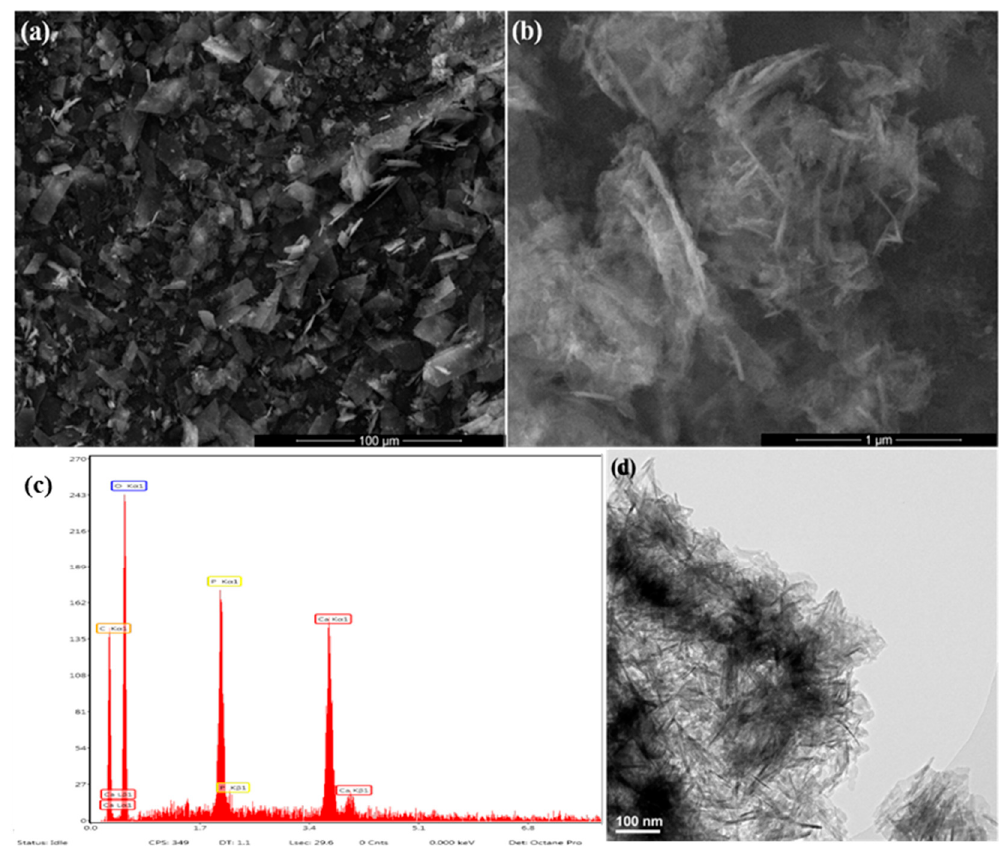
Figure 2. SEM images ( a , b ), energy-dispersive X-ray spectroscopy (EDS) spectrum ( c ) and TEM micrograph ( d ) of HAp powder.